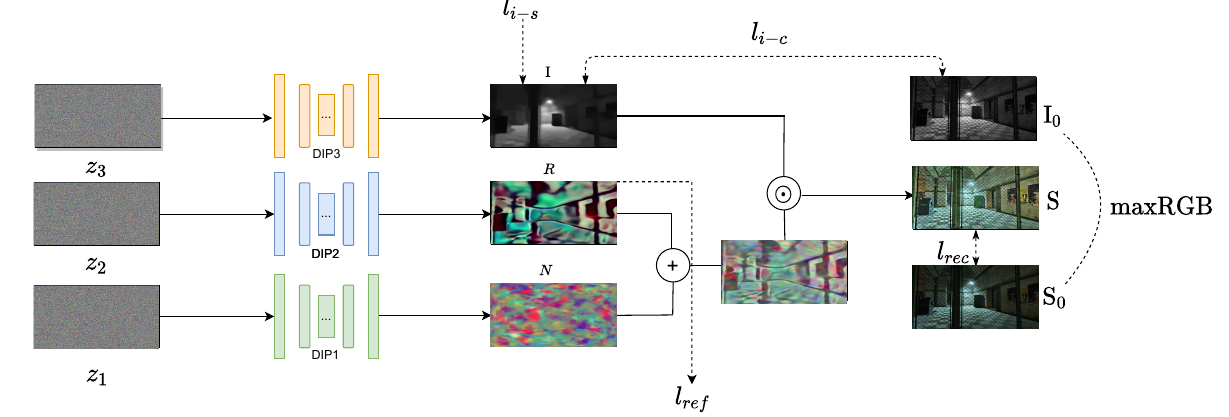
Figure 1. Overall framework of our method, where z 1,2,3 ∼ N ( 0, σ 2 ) signify Gaussian noise. DIP1 is used to generate noise N , and DIP2 and DIP3 are used to generate the reflectance R and the latent illumination I . l rec , l i − c , l ref , and l i − s represent reconstruction loss, illumination-consistency loss, reflectance loss, and illumination smoothness loss, respectively. I 0 is the initial illumination, S 0 is the input image, and S is the enhanced